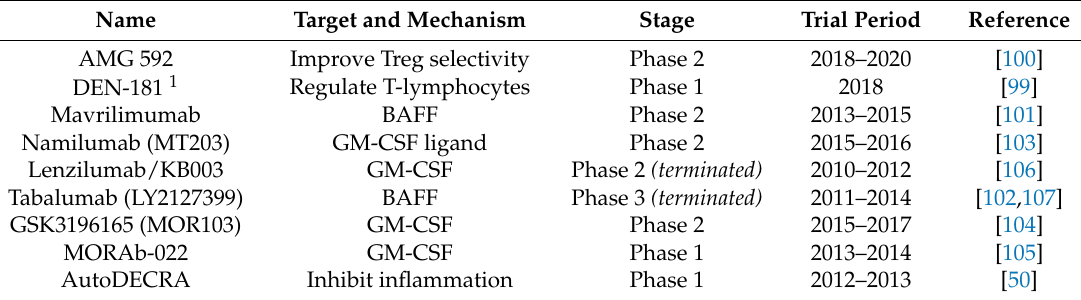
Table 3. Potential drugs for the treatment of rheumatoid